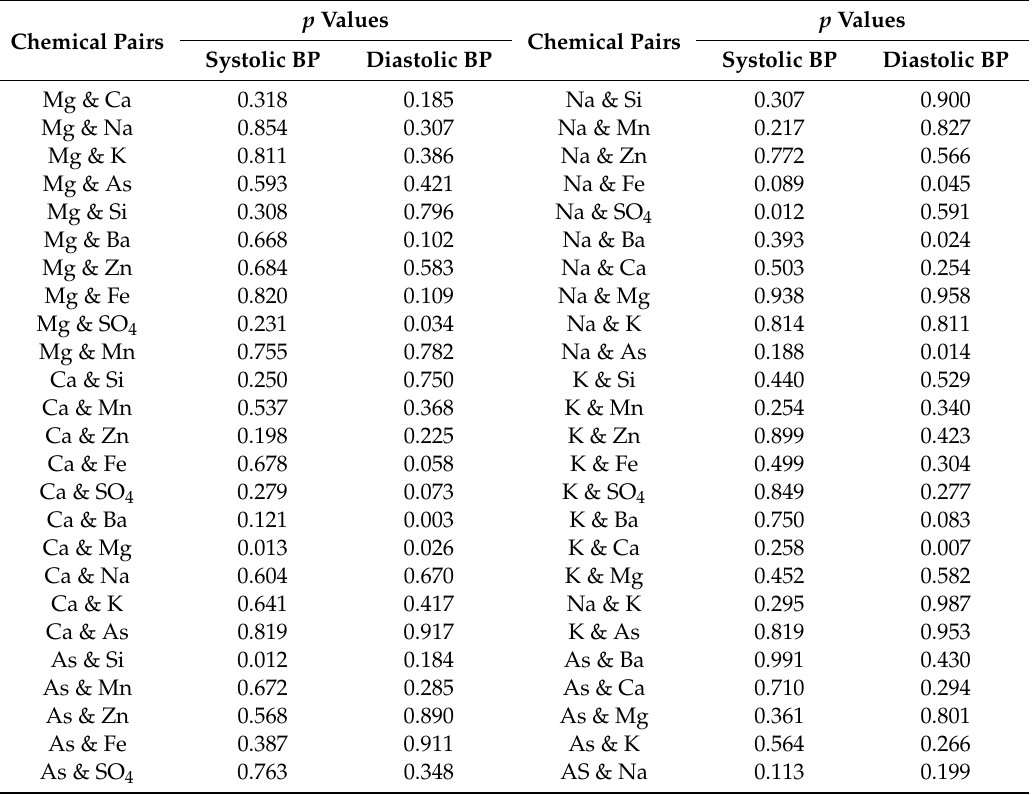
Table 3. Tests of pair-wise interactions between groundwater chemicals in relation to blood pressure outcomes. Associations were Bonferroni-significant at α =